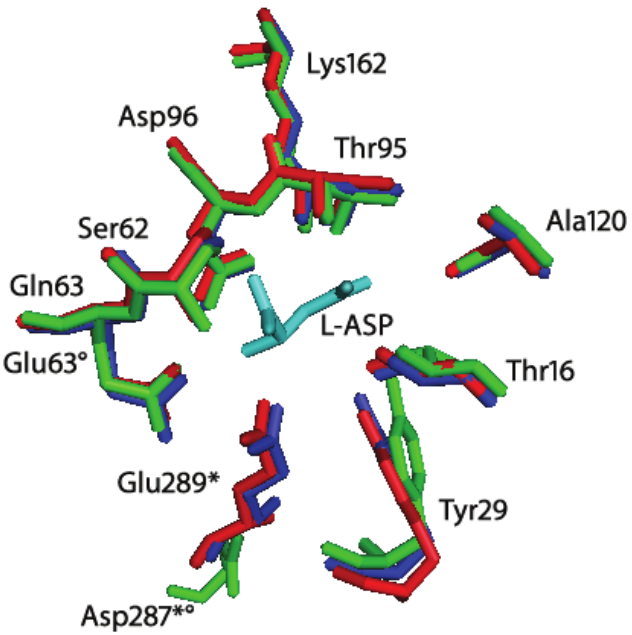
Figure 3. Superimposition of Helicobacter pylori J99 (HpA, PDB ID: 2WLT, red), Escherichia coli (EcA, PDB ID: 3ECA, blue) and Erwinia chrysanthemi (EwA, PDB ID: 1JSR, green) L -asparaginases active site residues. In cyan: L -Asp (reaction product). The residues are labeled according to the H. pylori enzyme residues number. * indicates